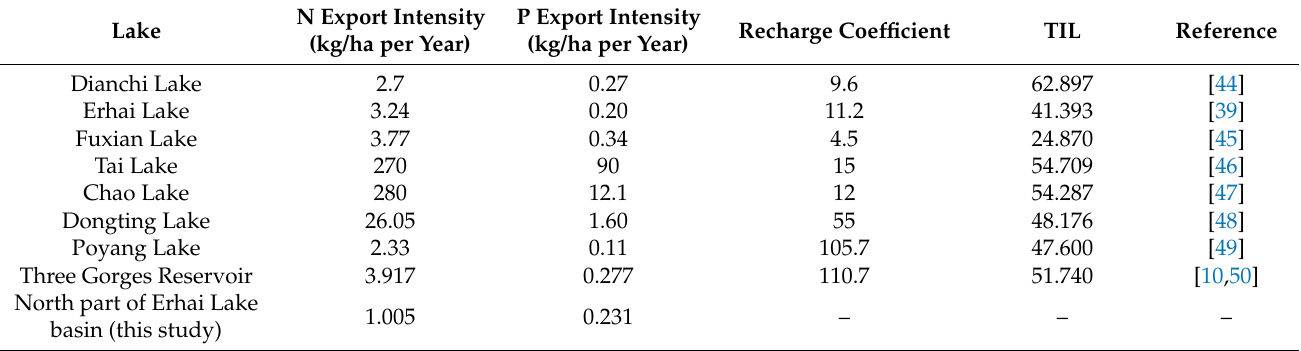
Table 7. Comparison of N and P export intensity in different lake